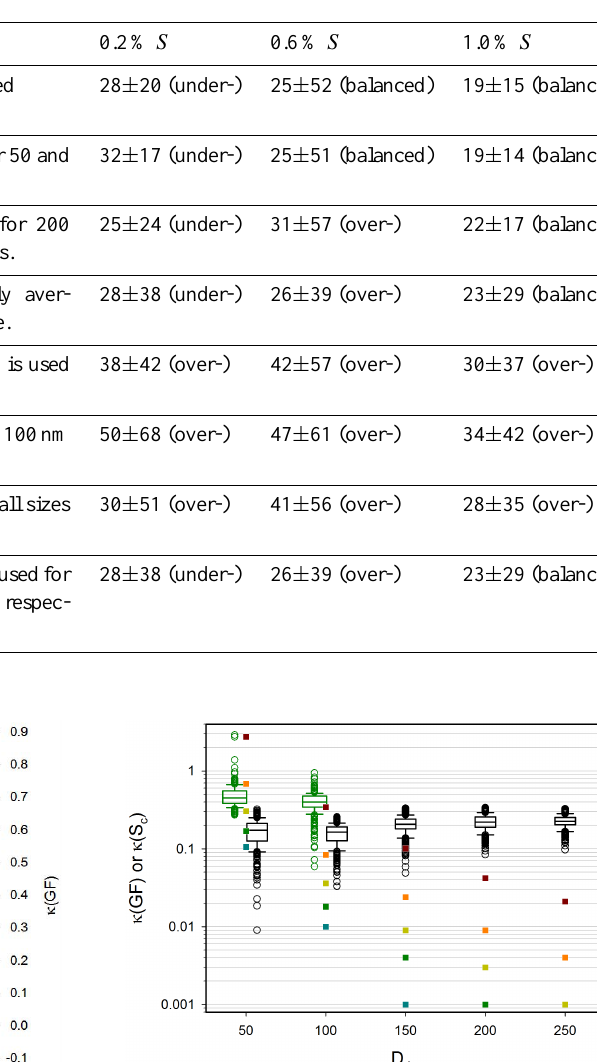
Table 5. Average and standard deviation of relative deviation, defined as | N CCN pred − N CCN meas | /N CCN meas , for different CCN closure methods using the GF and Sc data. The values are given in units of percent and the word in the parentheses indicates whether the closure results are dominated by underprediction (under-), overprediction (over-) or balanced.